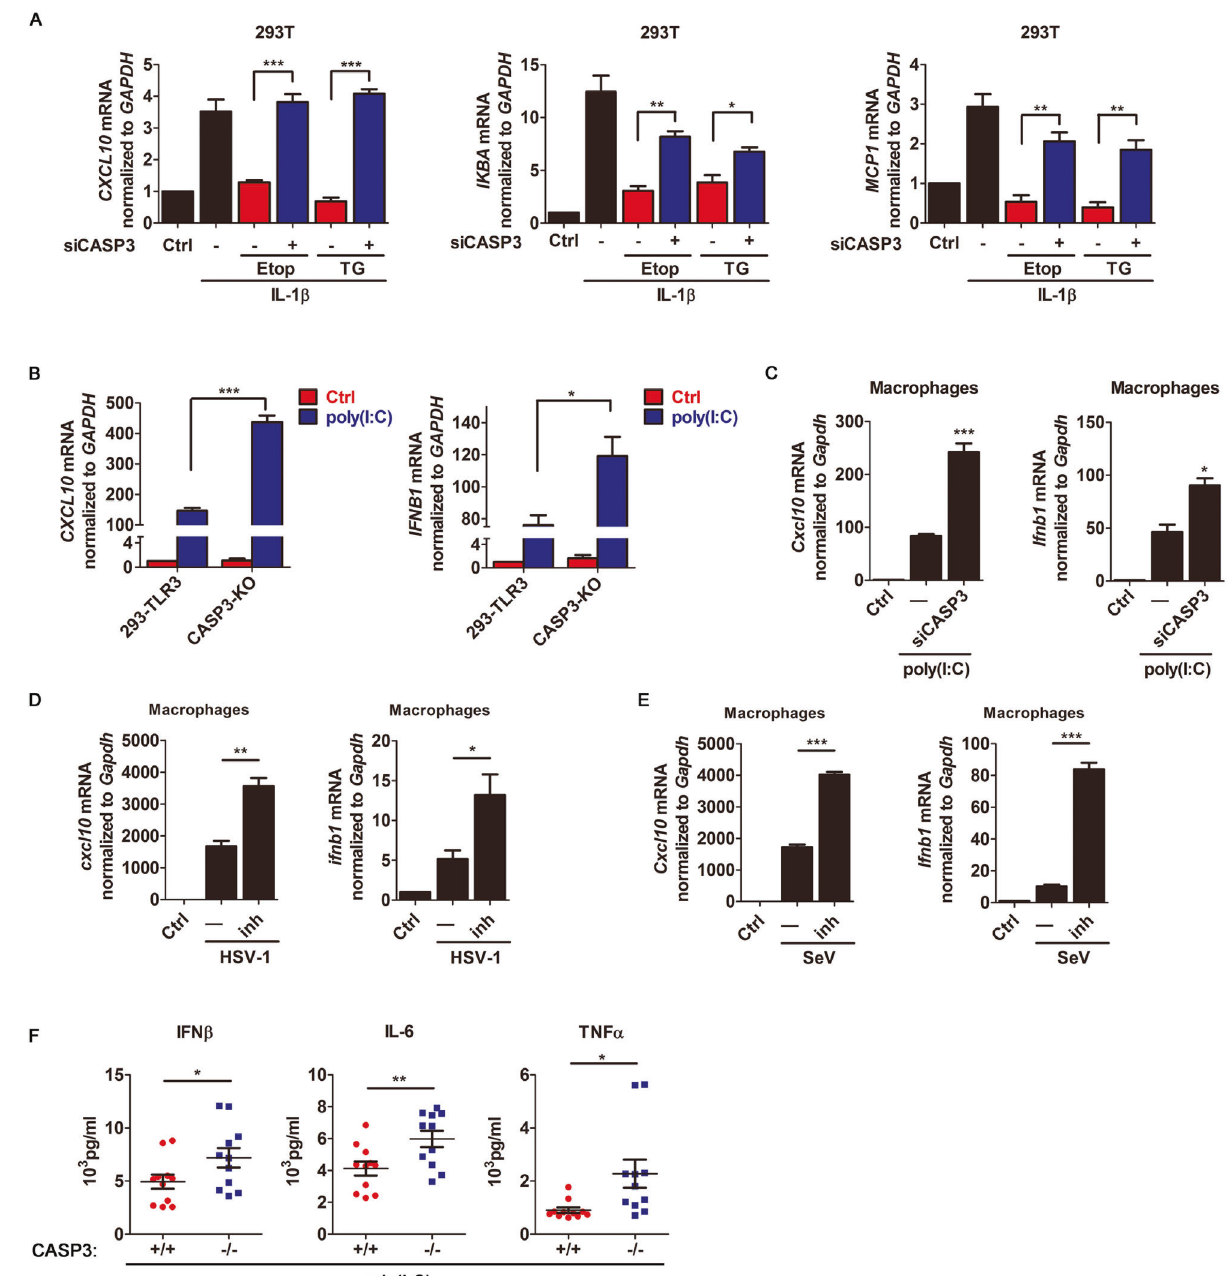
Fig. 2 Caspase-3 downregulates cytokine production. A Quantitative RT-PCR analysis of CXCL10 , IKBA and MCP1 mRNA in 293 T cells transfected with CASP3-speci fi c siRNA (siCASP3) and treated with IL-1 β (10 ng/mL) for 4 h in the presence or absence of Etop and TG as indicated. B Quantitative RT-PCR analysis of CXCL10 and IFNB1 mRNA in 293-TLR3 and CASP3-KO 293-TLR3 cells treated with or without poly(I:C). C Quantitative RT-PCR analysis of Cxcl10 and Ifnb1 mRNA in primary mouse peritoneal macrophages transfected with control siRNA or indicated siRNA in the absence or presence of poly(I:C). D , E Quantitative RT-PCR analysis of Cxcl10 and Ifnb1 mRNA in primary mouse peritoneal macrophages treated with or without z-VAD-FMK and infected with HSV ( D ) or SeV ( E ) for 8 h. F CASP3 + / + and CASP3 − / − mice were injected with poly(I:C) for 2 h. Serum concentrations of the indicated cytokines were measured by ELISA. Data are representative of three independent experiments (means with SEMs). * p < 0.05, ** p < 0.01, and *** p <